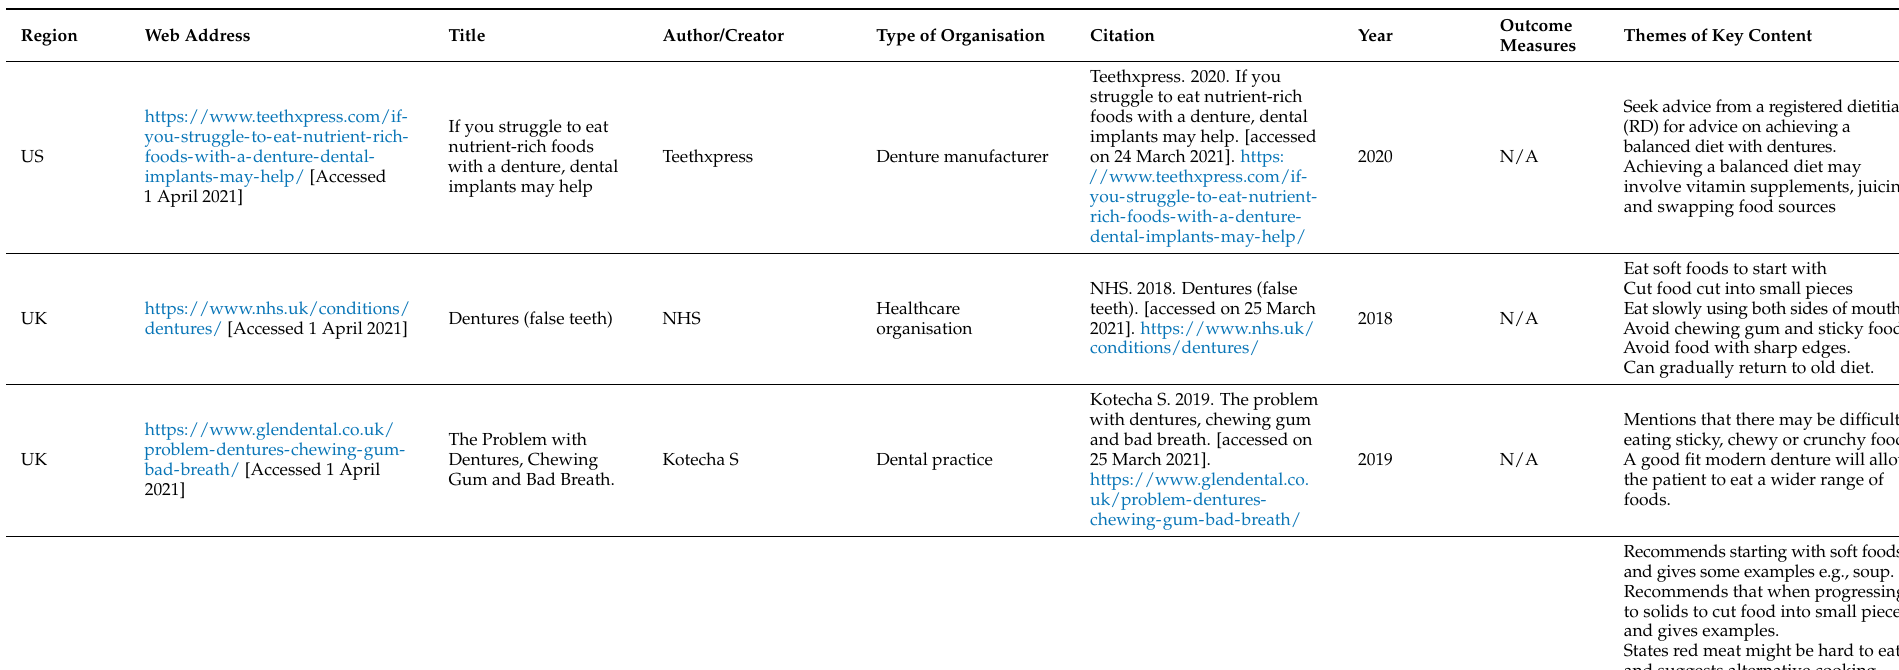
Table A2. Data charting form and data mapped from selected